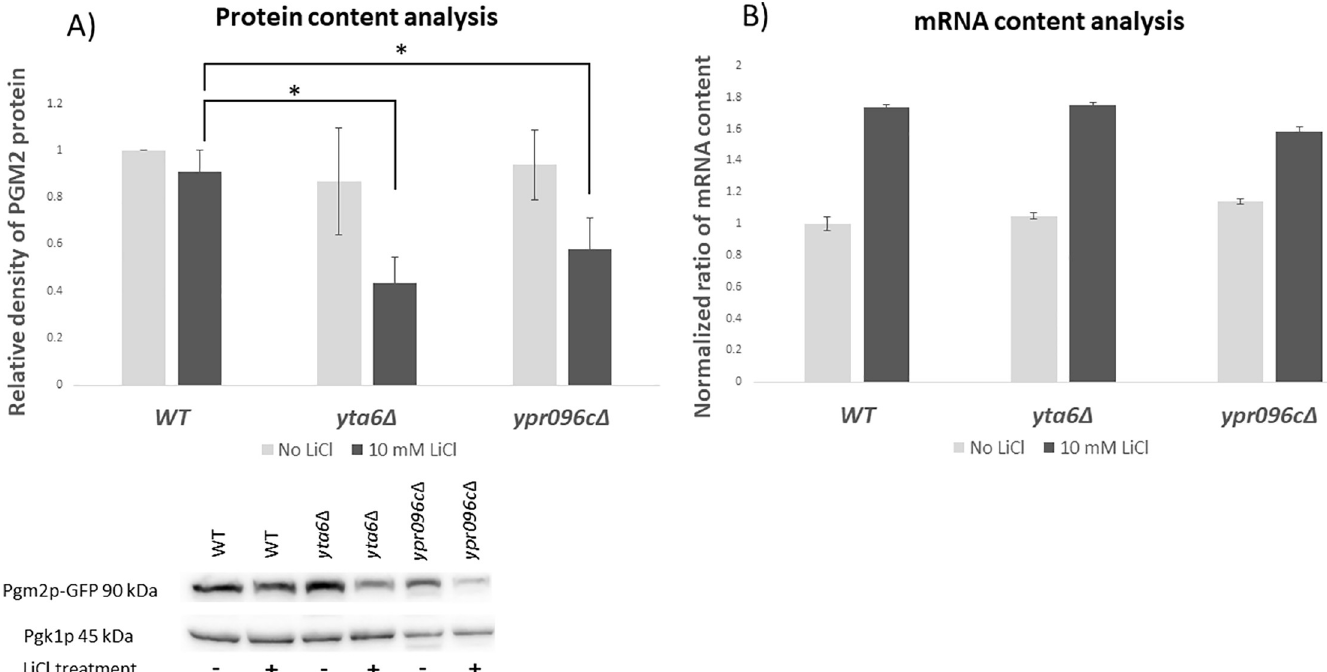
Fig 3. Protein and mRNA content analysis. (A) Protein content analysis of Pgm2p-GFP protein in deletion of yeast strains for yta6 Δ and ypr096c Δ . Western blot analysis was used to measure the protein content for Pgm2p-GFP protein in the absence or presence of LiCl (10 mM) and related to WT. Pgk1p was used as a housekeeping gene and the values are normalized to that. The inset represents a typical blot (B) mRNA content analysis of PGM2 in yta6 Δ and ypr096c Δ . qRT-PCR was used to evaluate the content of PGM2 mRNA in yeast gene deletion mutants related to WT strain and normalized to PGK1 mRNA levels in the absence or presence of LiCl (10 mM). Each experiment was repeated at least three times (n � 3). Error bars represent standard deviation. � represent statistically significant results compared to the value in the corresponding WT. t-test analysis ( P -value � 0.05) was used to compare differences.